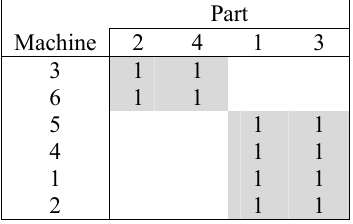
Fig. 2. Perfect block diagonal